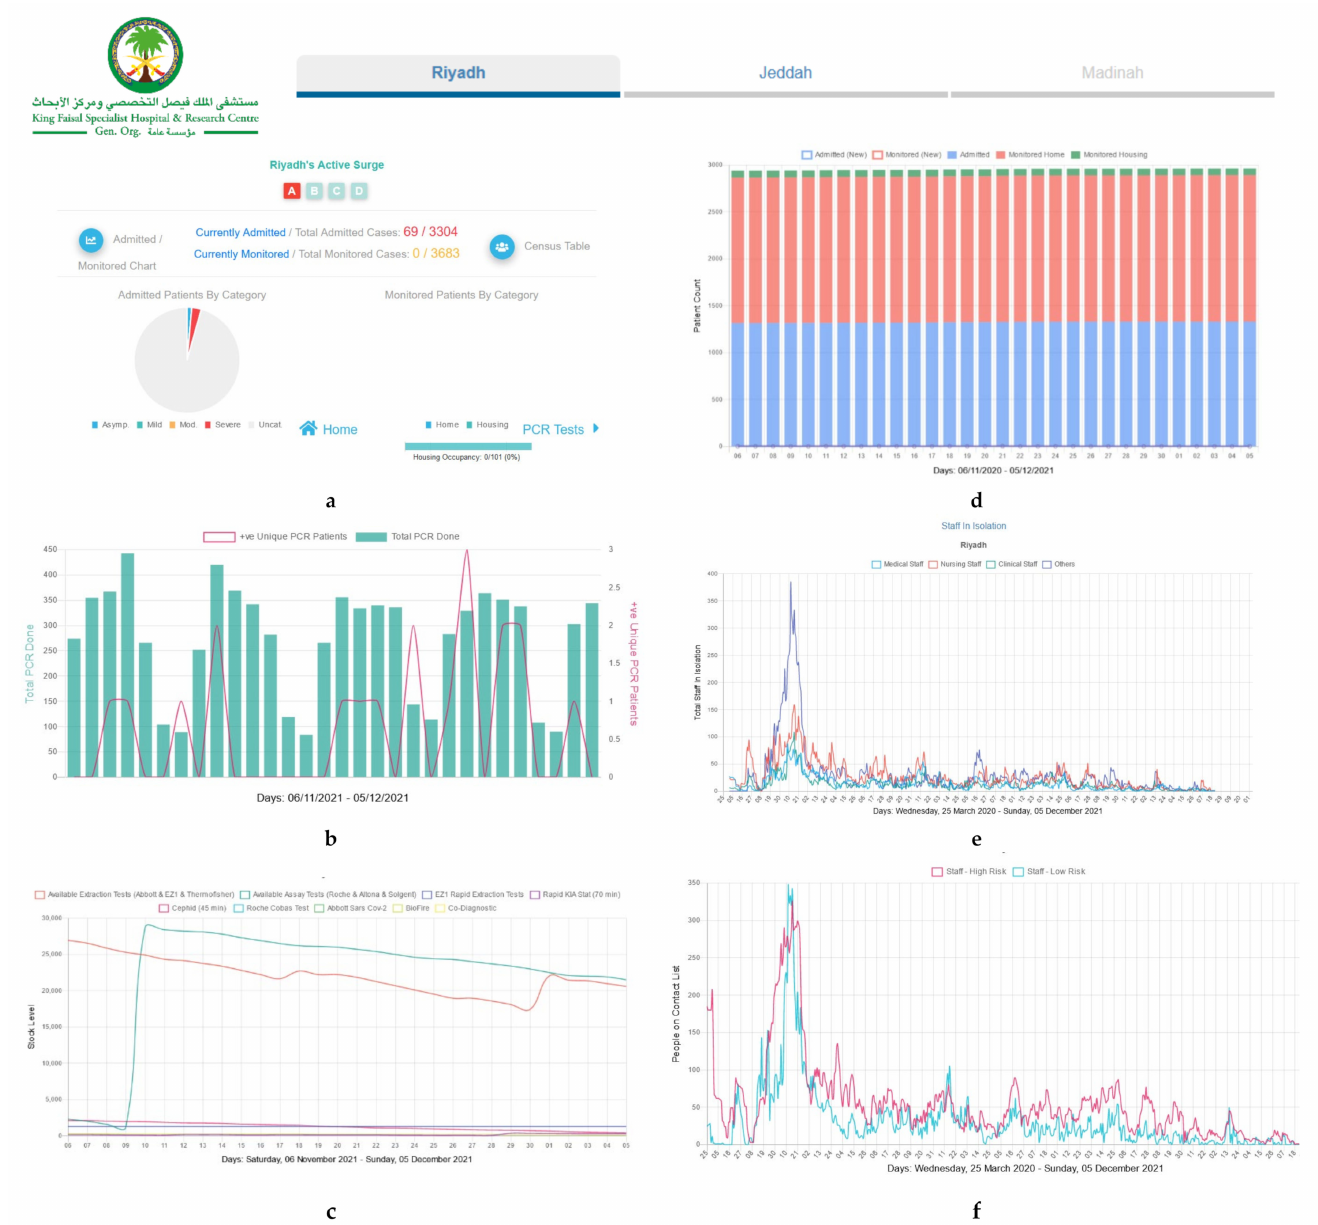
Figure 2. ( a ) Monitored patients per Severity level and Surge Level. ( b ) Number of PCR Tests Total and (+ve). ( c ) Monitored PCT test kits. ( d ) Patients Location. ( e ) Hospital staff in isolation. ( f ) Exposed staff as per contact list